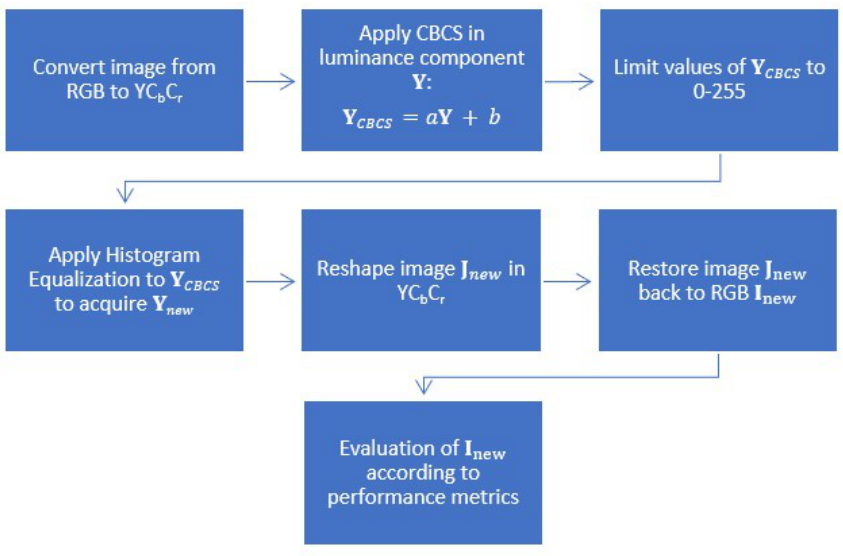
Figure 1. Block diagram of the proposed